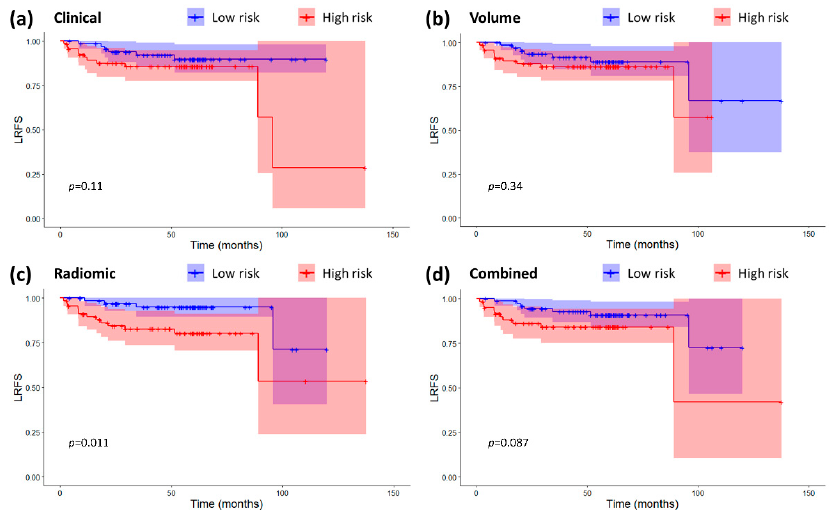
Figure 3. Kaplan-Meier curves and confidence intervals for loco-regional recurrence-free survival (LRFS) in the high and low risk groups as defined by the four prognostic models. ( a ) Clinical model. ( b ) Volume-based model. ( c ) Radiomic model. ( d ) Combined radiomic-clinical model. The p -values for the log-rank tests are also displayed on the plots. Crosses represent censored data.